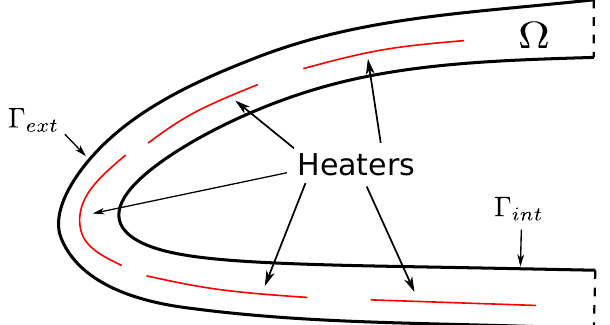
Figure 4. Illustration of an electrothermal ice protection system. The red lines represent the heater